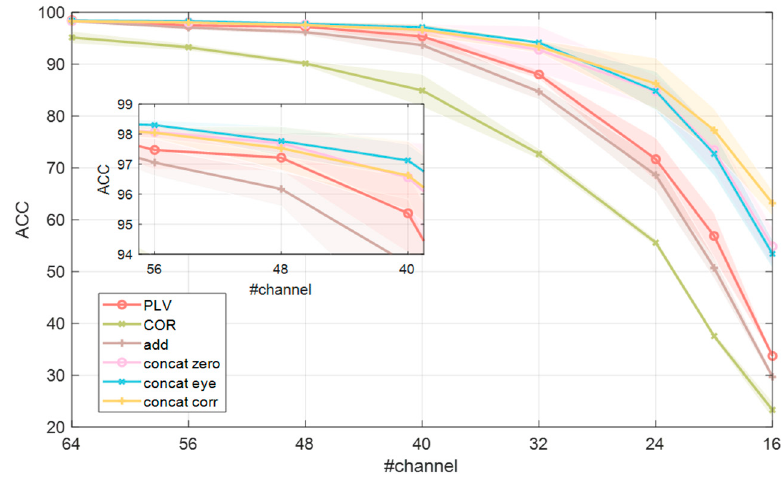
Figure 6. Performance comparison of different methods at the different levels of channel reduction (64, 56, 48, 40, 32, 24, 20, and 16 channels remain). It can be seen that the accuracy of multiple FCs with the concat-fusion declines slowly. When the number of channels is reduced to 40, the concat-fusion still maintains more than 97.13% accuracy. When the number of channels is greater than 32, the concat method shows a significant advantage. Table 5. Accuracy of single FC and multiple FCs under different number of channels.